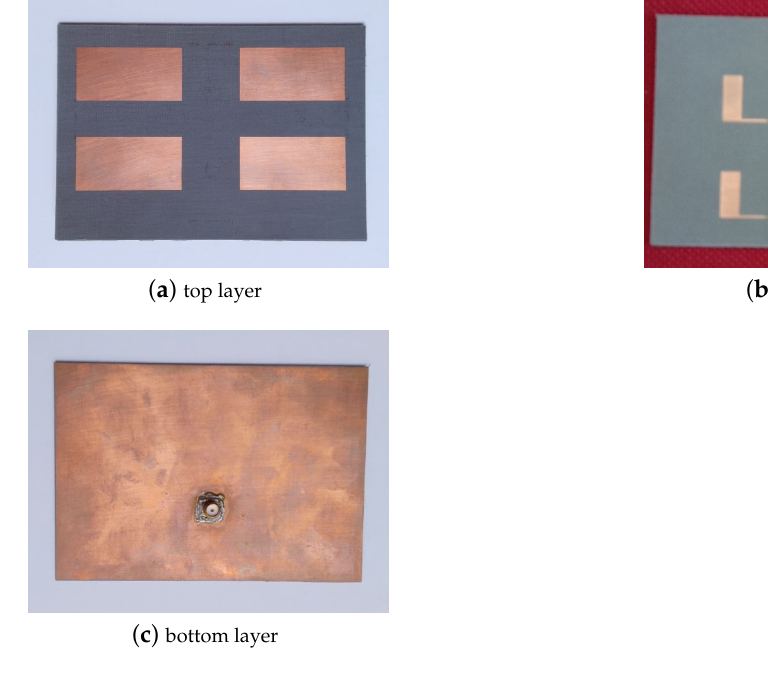
Figure 2. The fabricated 2 × 2 microstrip array antenna design.